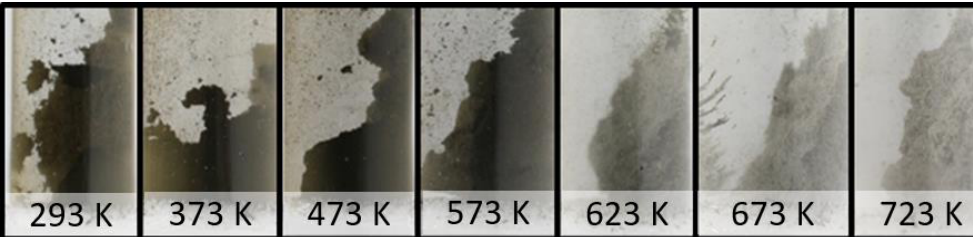
Figure 4. Reactivity test series of (d) C12A7e − (3C) under forming gas (95% N 2 /5% H 2 ) atmosphere inside the quartz-glass tube. From left to right: pictures of the sample after heating for each 1 h at the respective temperature.